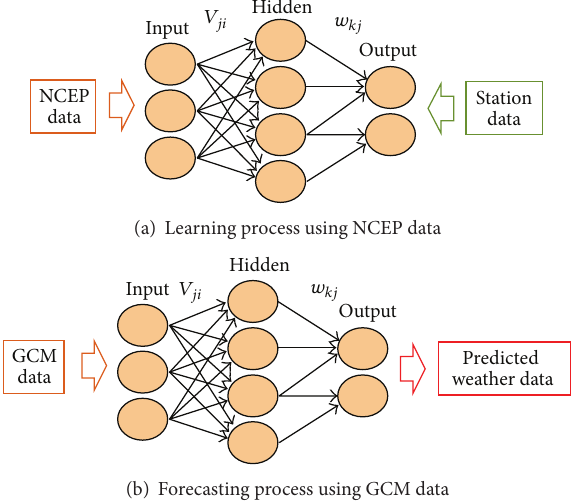
Figure 2: Downscaling technique using